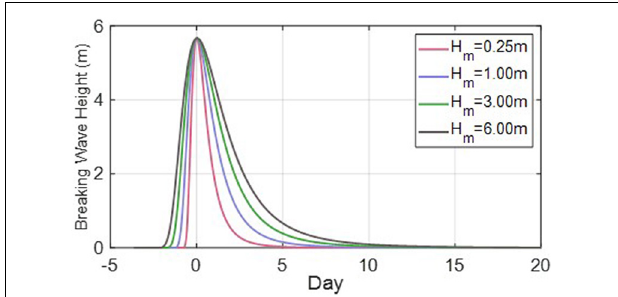
FIGURE 13 | Temporal variation of breaking wave height according to H ( = H m ) ( H o p = 6 . 0 m and a r = 0 . 007 m and k r = 0 . 08 d − 1 ).